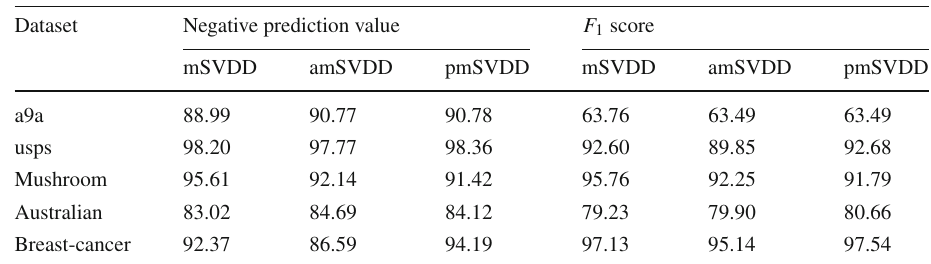
Table 7 Negative prediction value (in %) and F 1 score (in %) comparison